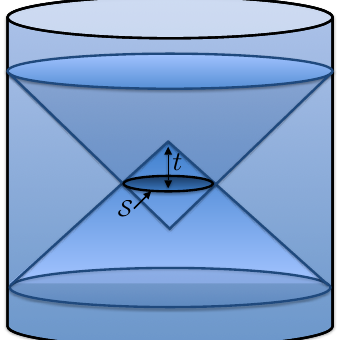
Figure 2 . A small causal diamond in AdS consisting of the domain of dependence of the ball bounded by the holographic screen . The ball lies in the t = 0 time slice, and is centered around S the origin. The location of with respect to the origin can be parametrized by the time t at which S the inward future lightsheet arrives at the